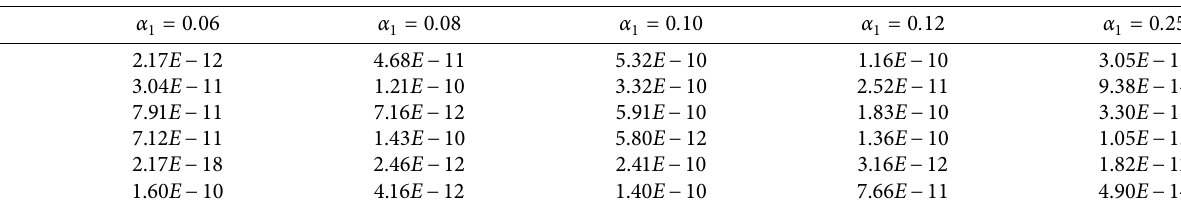
Table 8: Absolute errors obtained by the LeNN-WOA-NM algorithm for population density of the predator Y ( t ) under the influence of the intrinsic growth rate of local prey α . 1